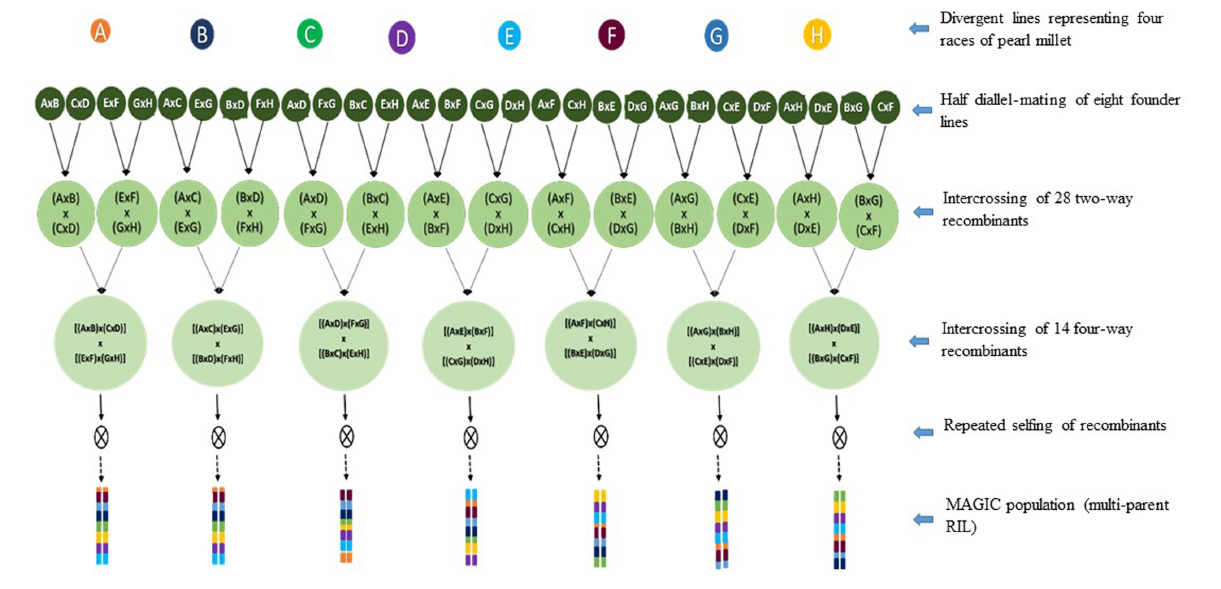
FIGURE 3 | Proposed crossing scheme for the development of multi-parent advanced generation inter-cross (MAGIC) population development for pearl millet. The scheme involves half-diallel mating of eight molecularly diverse inbred germplasm, intercrossing of the recombinants, and repeated selfing to develop multi-parent recombinant inbred